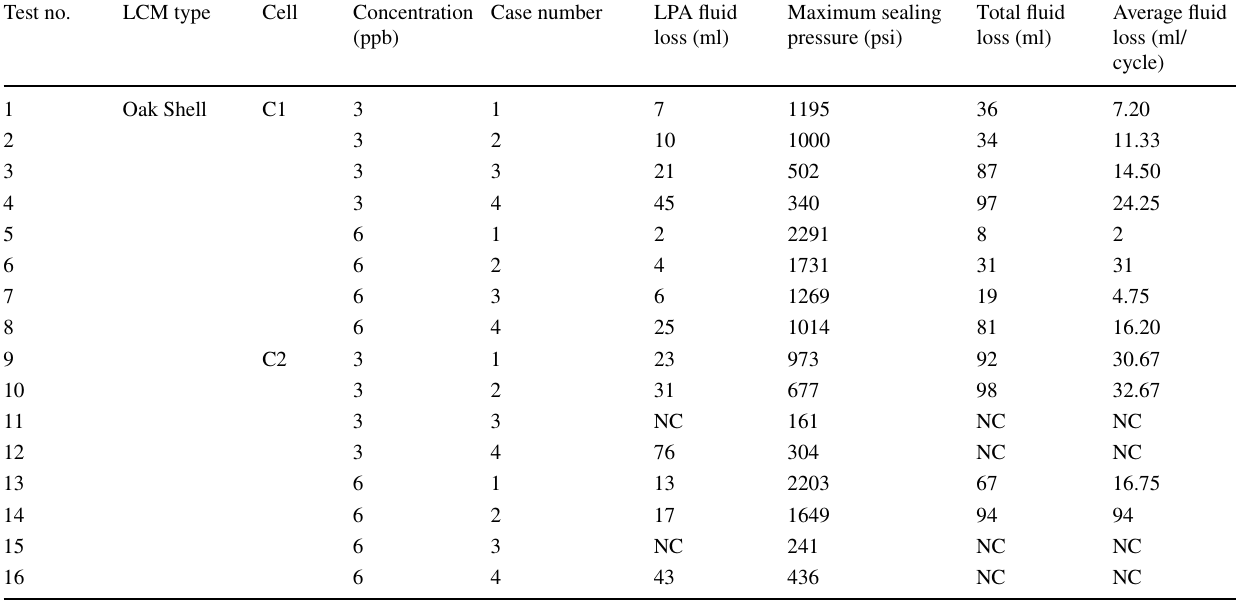
Table 9 Summary of HPA testing results for Oak Shell Test no.